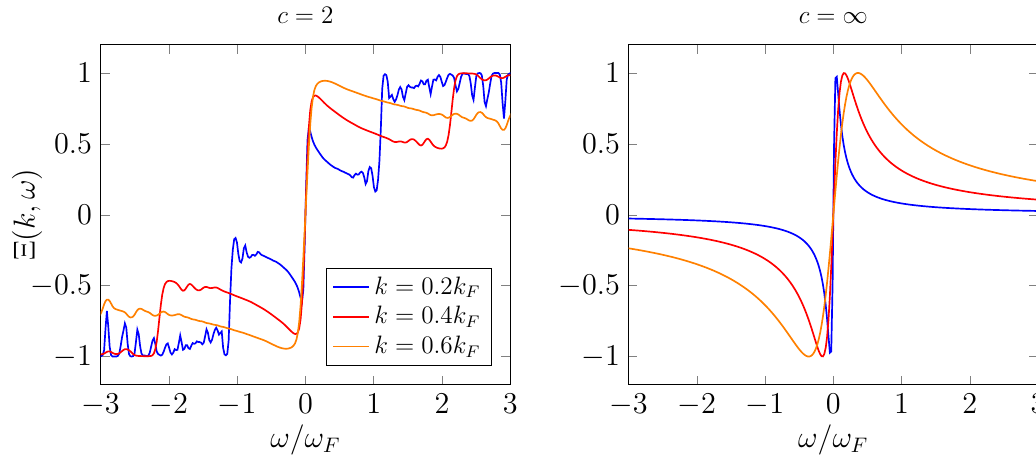
Figure 7: Dependence of the fluctuation-dissipation ratio Ξ ( k , ω ) on ω/ω = k 2 energy ω as calculated from the post-quench diagonal ensemble (39) for the three F F different values of k indicated in the legend, corresponding to the same data and quenches as in Fig. 6. The left and right panels correspond to a quench to c = 2 and c → ∞ , respectively. The abrupt increase in Ξ ( k , ω ) at c = 2 (for example at k = 0.2 k the rapid oscillations are a numerical artifact due to the numerical truncation of the sum over the diagonal ensemble